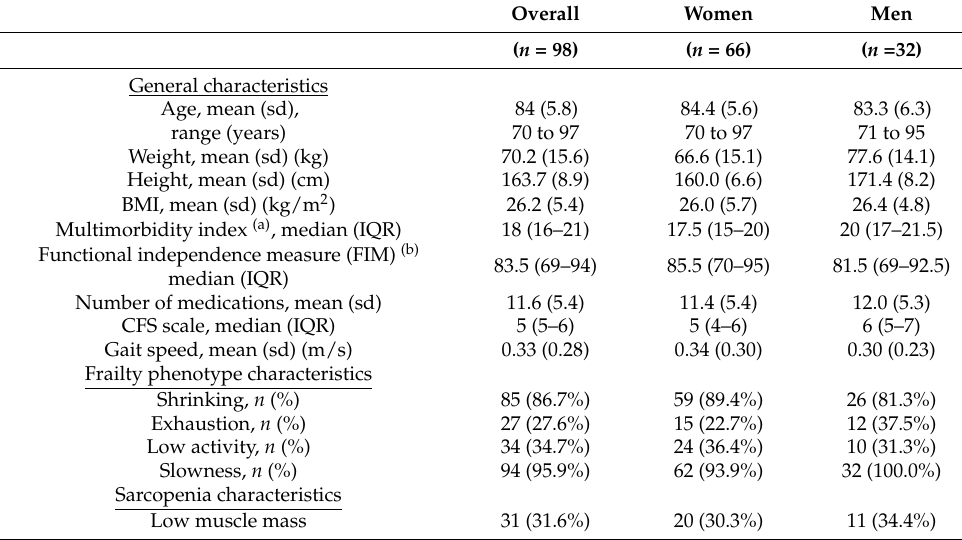
Table 2. Study population characteristics ( n =